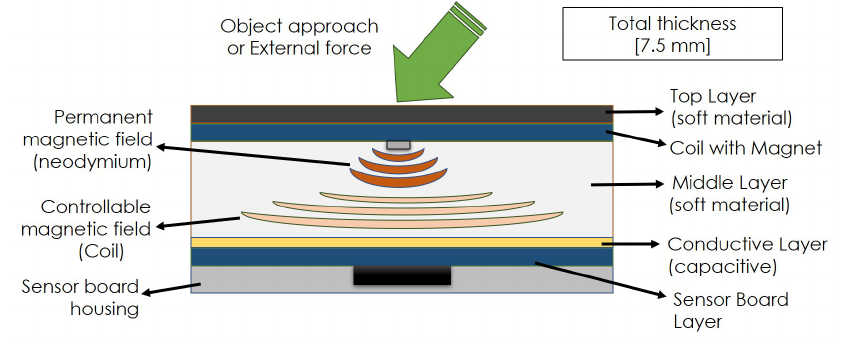
Figure 1. Layers of sensor